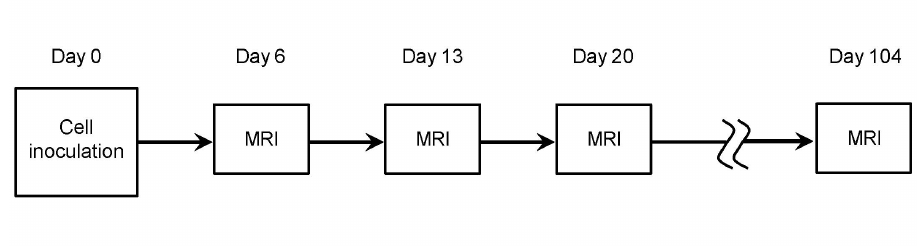
Figure 2. Experimental design. Timeline for cell inoculation and magnetic resonance imaging (MRI).